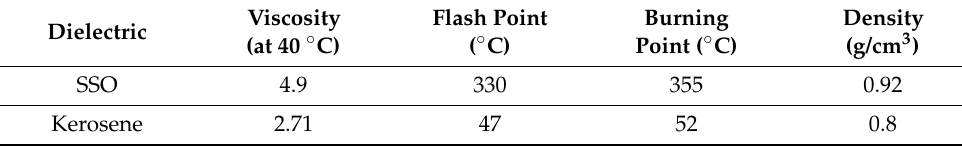
Table 2. Comparison of physical properties of SSO and Kerosene.